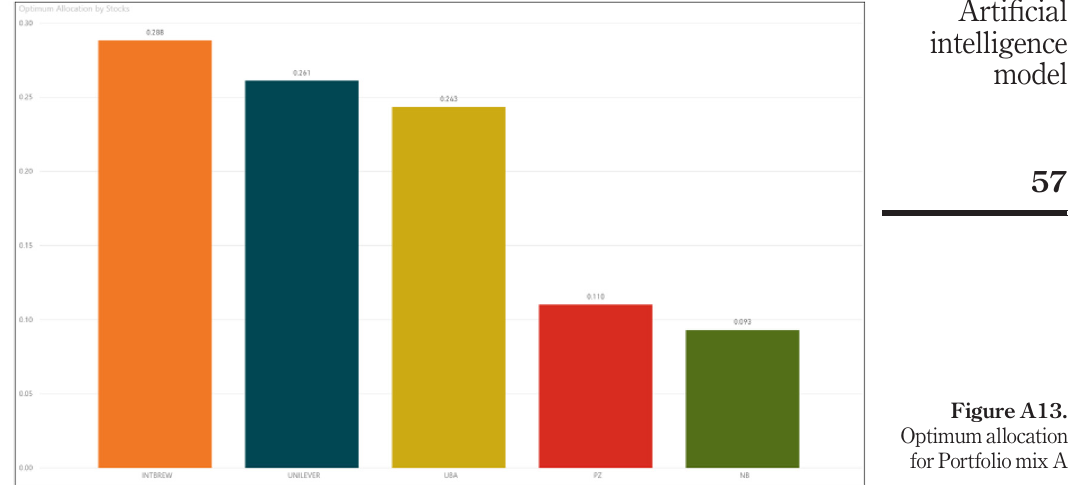
Figure A13. Optimum allocation for Portfolio mix